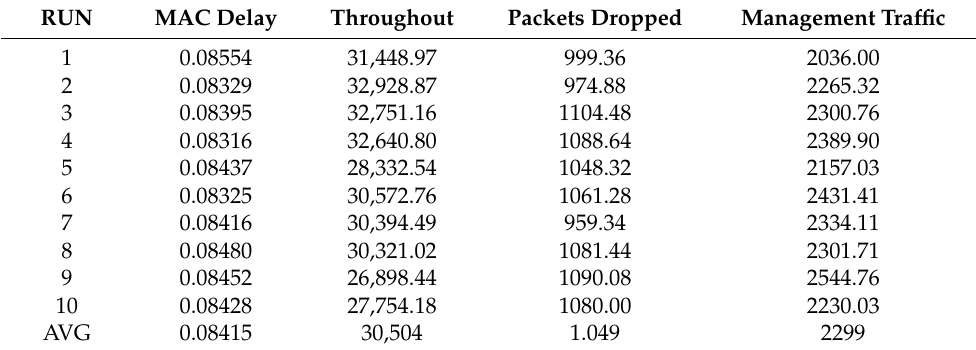
Table 7. Randomized Scenario Tabu Search.